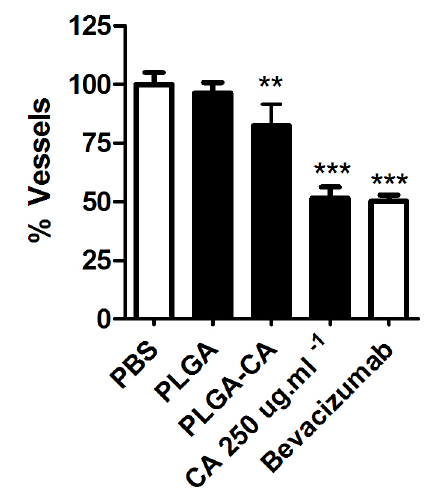
FIGURE 7 - CAM assay performed with PBS pH 7.4 (negative control), the blank implant of PLGA; CA-loaded PLGA implant; CA suspension at 250 µg ml -1 and bevacizumab 250 µg ml -1 (positive control). The negative control was fixed at 100%. Results are expressed as mean (%)±SEM; *p<0.05; **p<0.01; ***p<0.001 compared to the negative